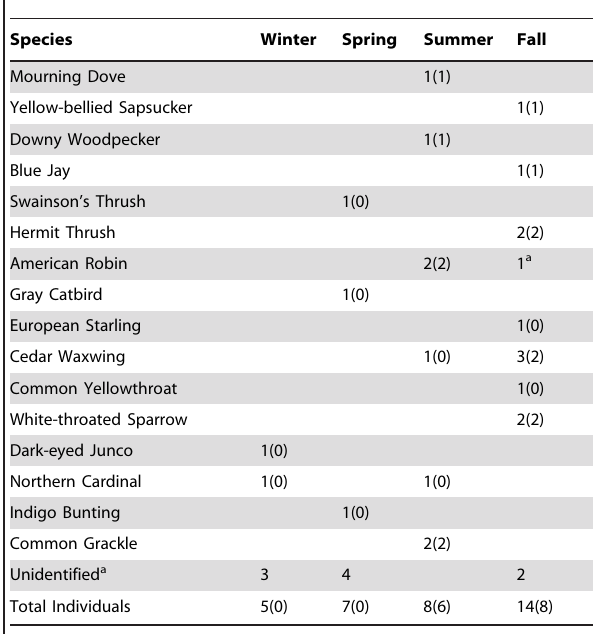
Numbers in parentheses represent a count of hatch-year individuals of each season’s